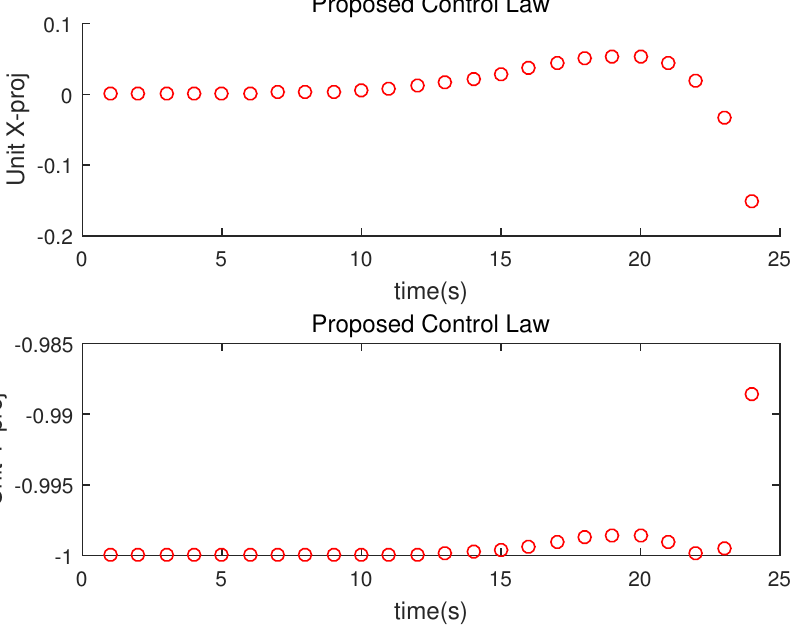
Figure 8. Plot of l for a maneuvering